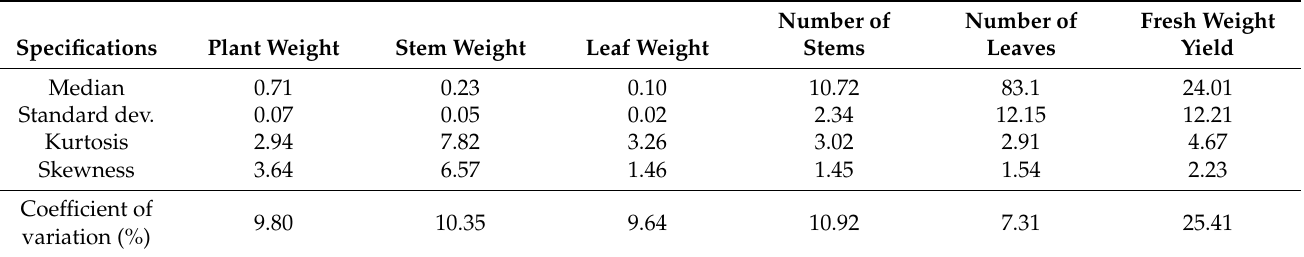
Table 8. Descriptive statistics of plant, stem and leaf weights, numbers of stems and leaves, and fresh weight yield of the aboveground parts of